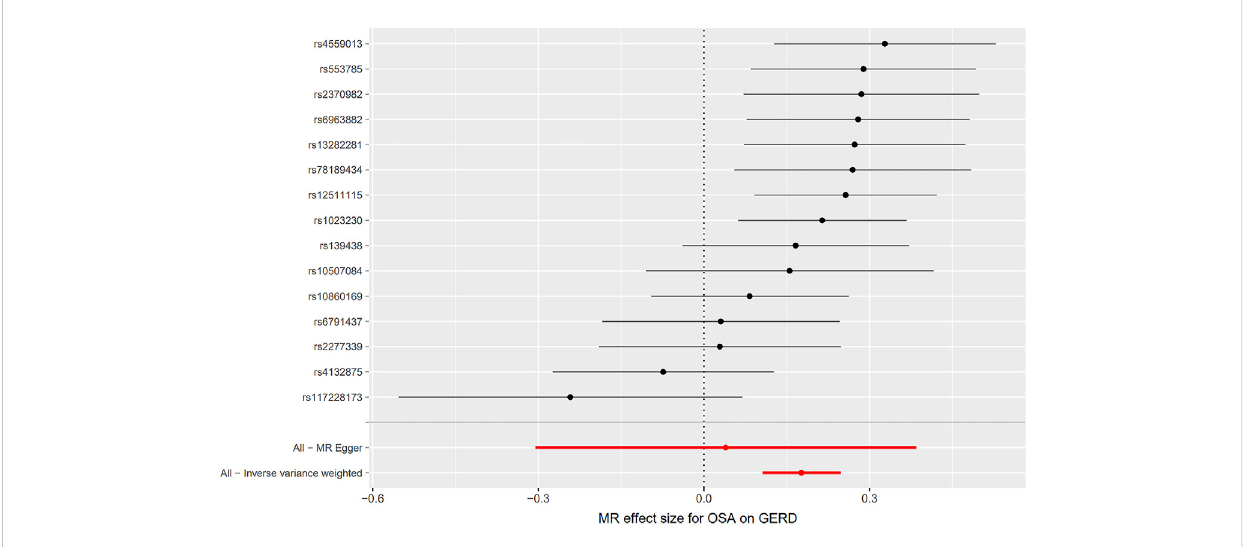
FIGURE 4 ForestplotforthecausalrelationshipofOSAonGERD.MR,Mendelianrandomization;OSA,obstructivesleepapnea;GERD,gastroesophagealre fl ux disease.